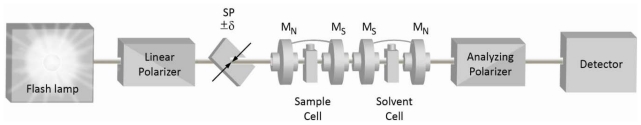
Apparatus for time-resolved measurements of magnetic circular dichroism. By addition of a magnet with the sample cell placed between the pole faces (MN, MS) and a compensator (solvent cell between pole faces of a second magnet), the TRCD approach can be extended to TRMCD measurements. The compensator counteracts the Faraday rotation of the probe beam polarization as it passes through the sample cell windows and the solvent in a magnetic field. It comprises a solvent blank in a cell matched with the sample cell and a magnetic field matched in magnitude but opposite in direction to that for the sample.